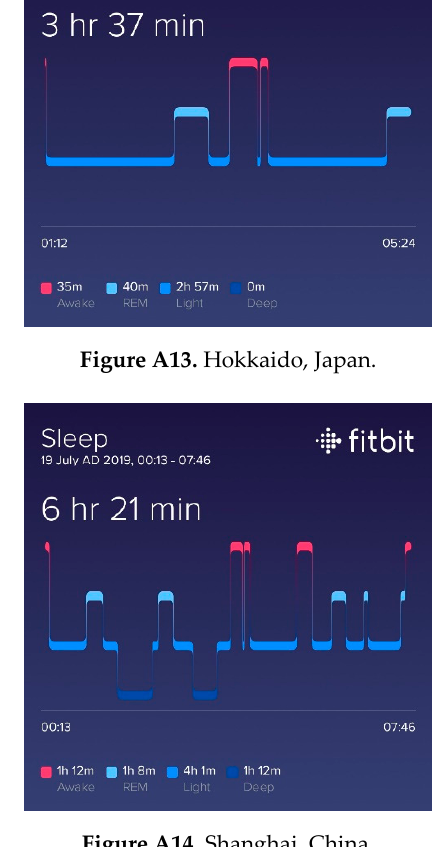
Figure A14. Shanghai, China.